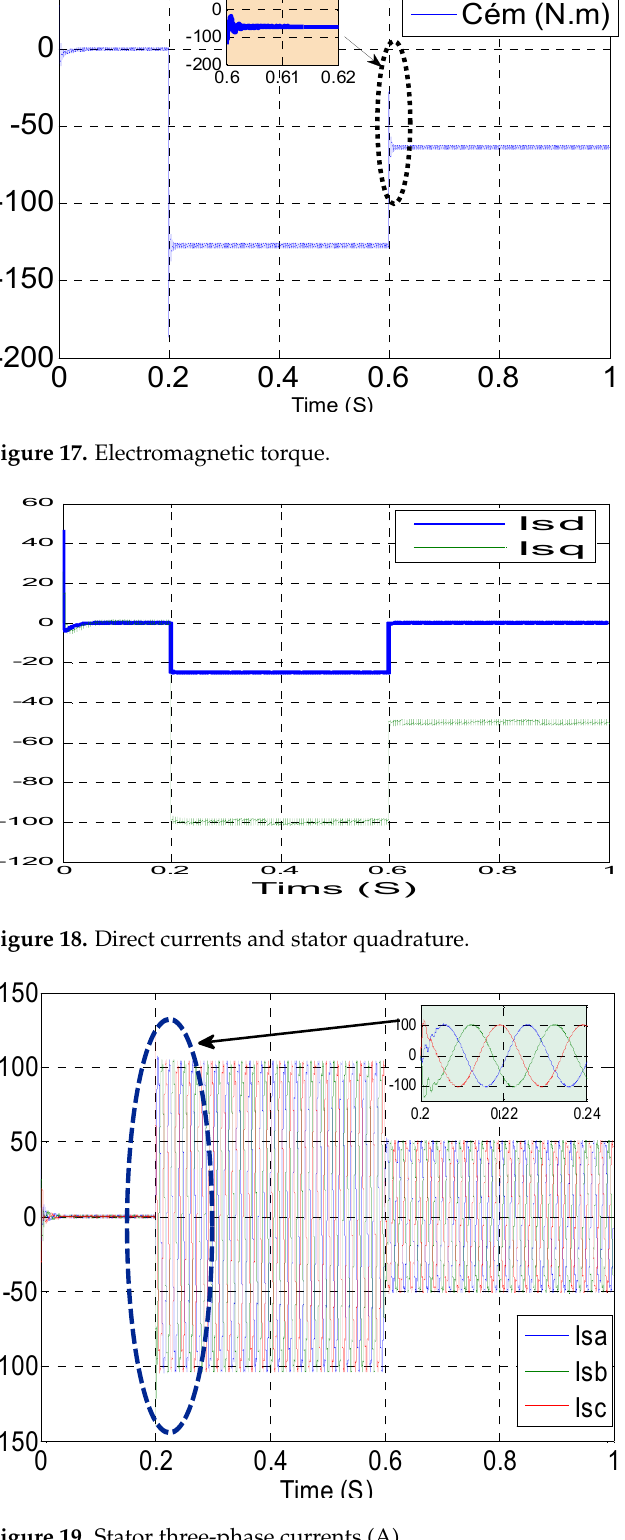
Figure 20. The stator current and voltage.